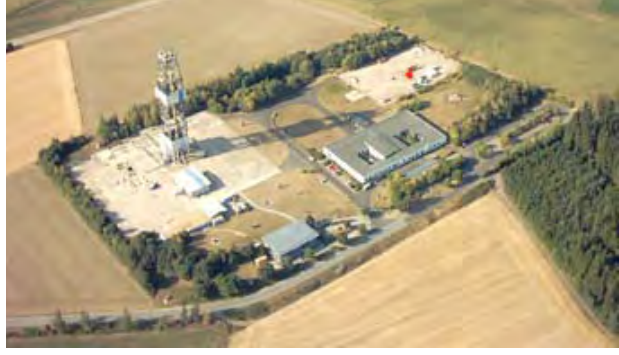
Figure 1. Aerial view of KTB site with former drill tower atop main hole KTB-HB and pilot hole KTB-VB in center of second light, rectangular area (red circle).